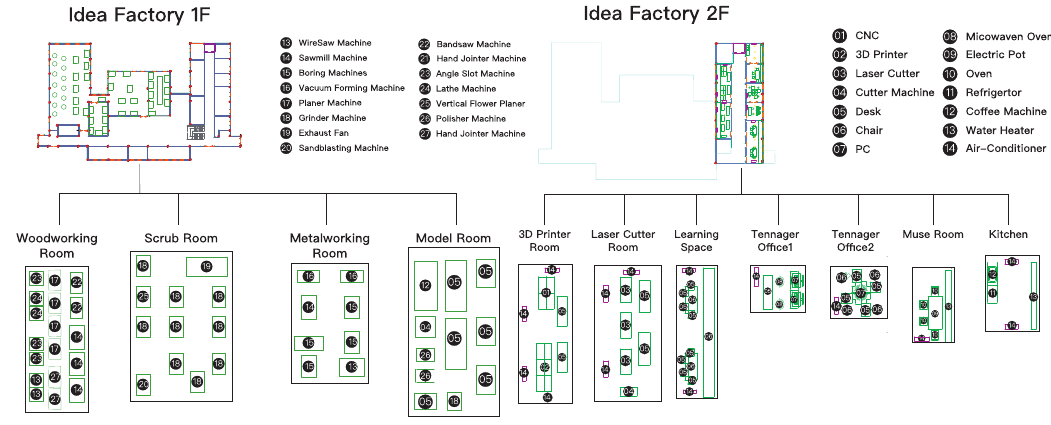
Figure 3. The facilities of the Idea